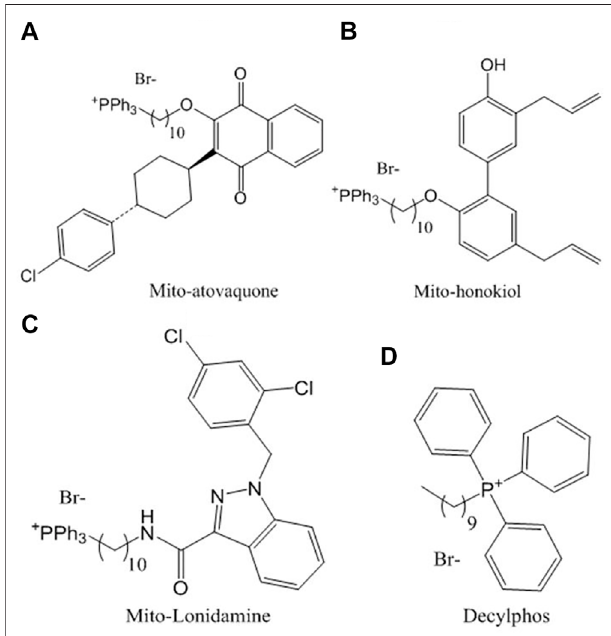
FIGURE 1 | Chemical structures of the compounds conjugated with triphenylphosphonium studied in this work: (A) ATO, (B) HNK, (C) LND and (D)